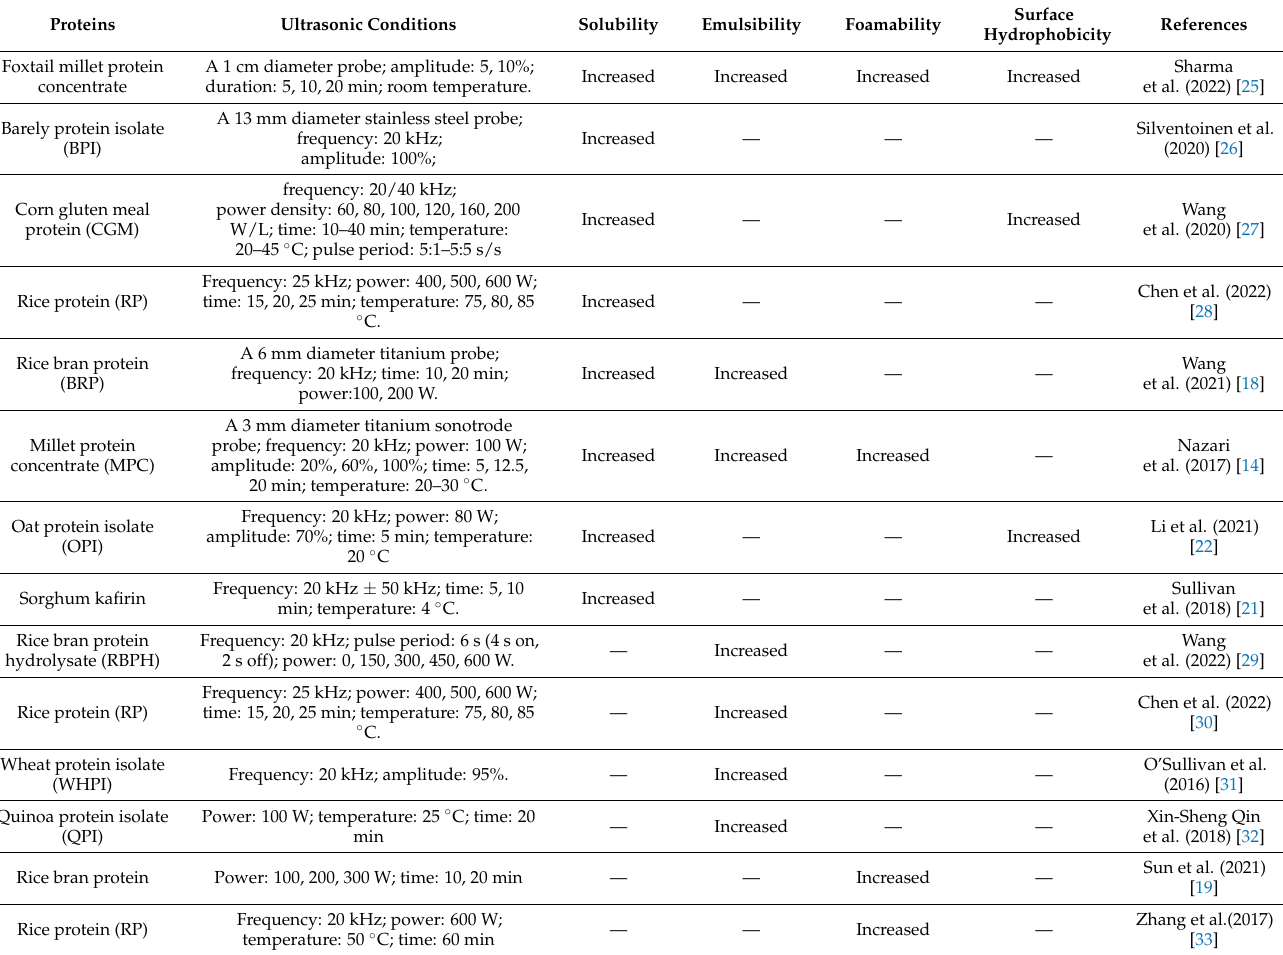
Figure 2. Schematic illustration of the ultrasonic generation of bubble cavitation and collapse [24]. Table 1. Summary of representative research on the functionality changes in modified CPs after ultrasonic treatment.